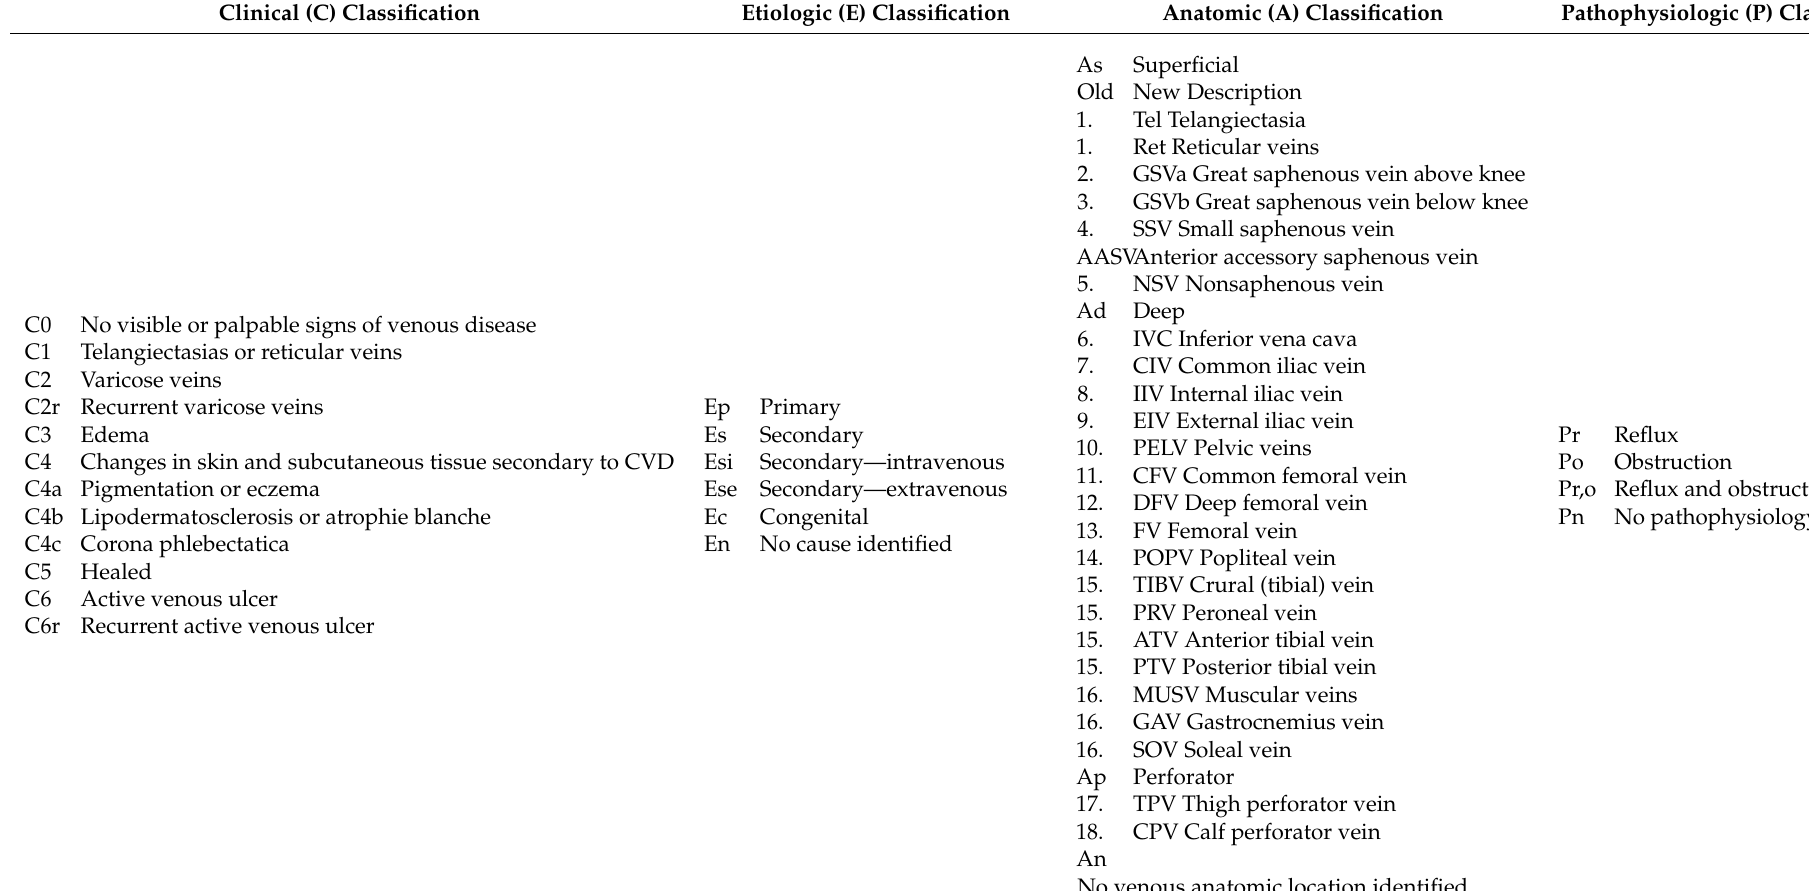
Table 1. Last revision of CEAP classification on